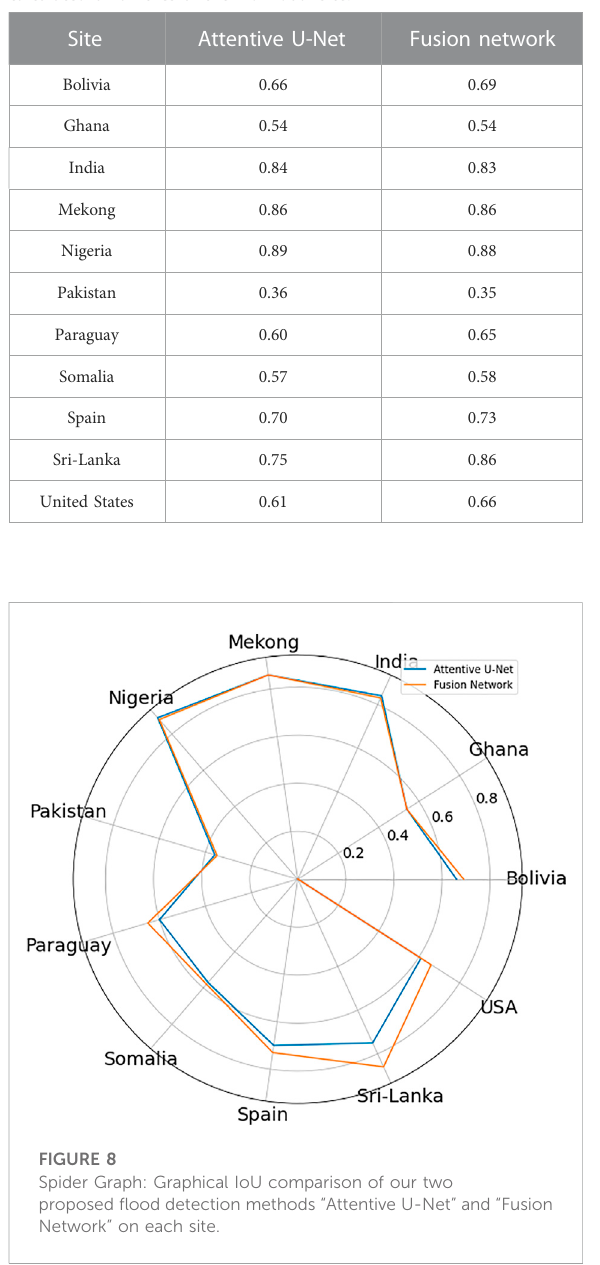
TABLE 3 Performance Comparison of Attentive U-Net and Fusion Network on each site. The displayed numeric values are the average IoU scores calculated on all tiles of the individual site.